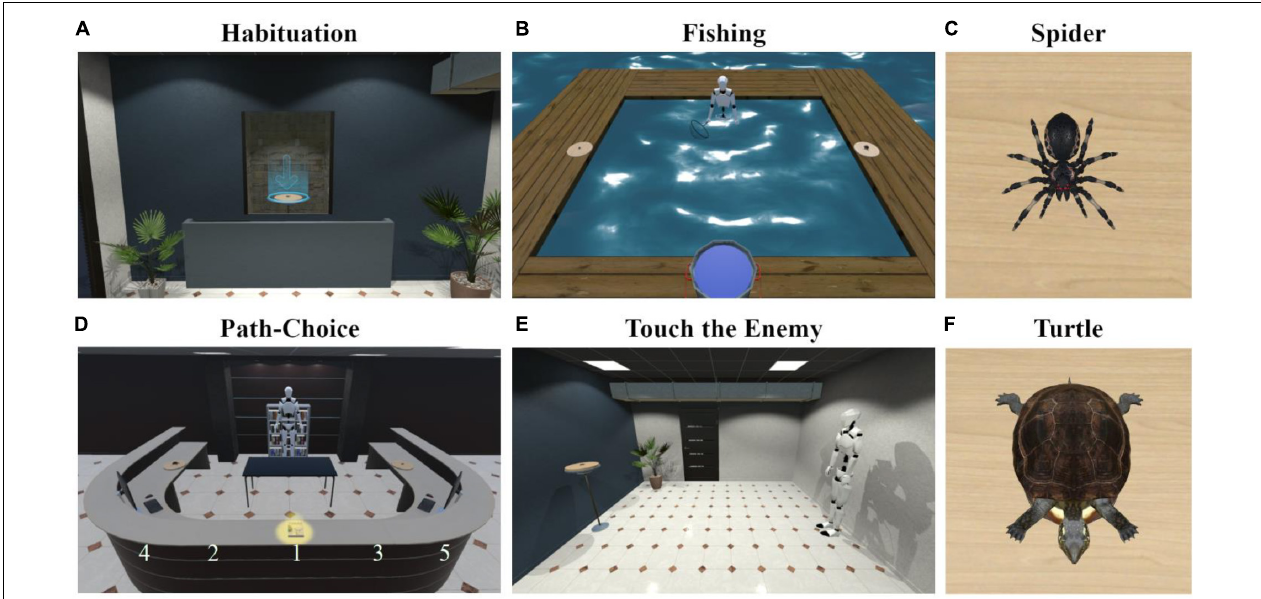
FIGURE 1 | Screenshots of the virtual reality scenes: (A) Habituation—first person view of the stimulus habituation with the blue arrow being present, (B) Fishing—the behavioral search task, (C) Spider—the aversive stimulus, (D) Path-Choice—the behavioral forced-choice task, the white numbers indicate the book position of the respective trial, (E) Touch the Enemy—the behavioral approach task, (F) Turtle—the control